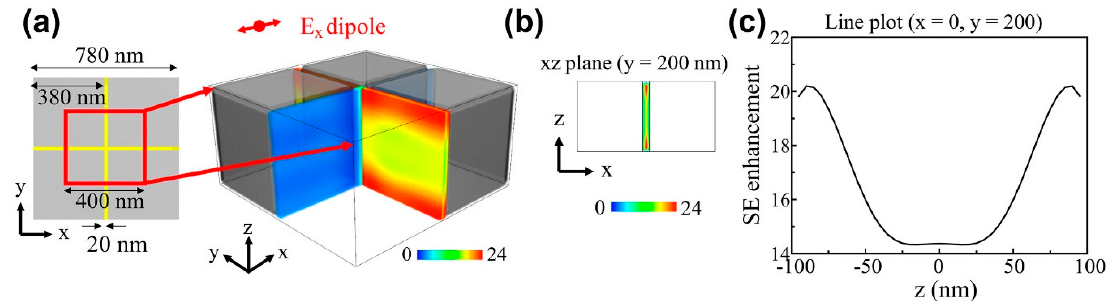
Figure 4. Spontaneous emission (SE) enhancement as functions of Ex dipole source location; ( b ) is SE enhancement in the XZ plane at y = 200 nm corresponding to ( a ); ( c ) is SE enhancement along the z - direction for